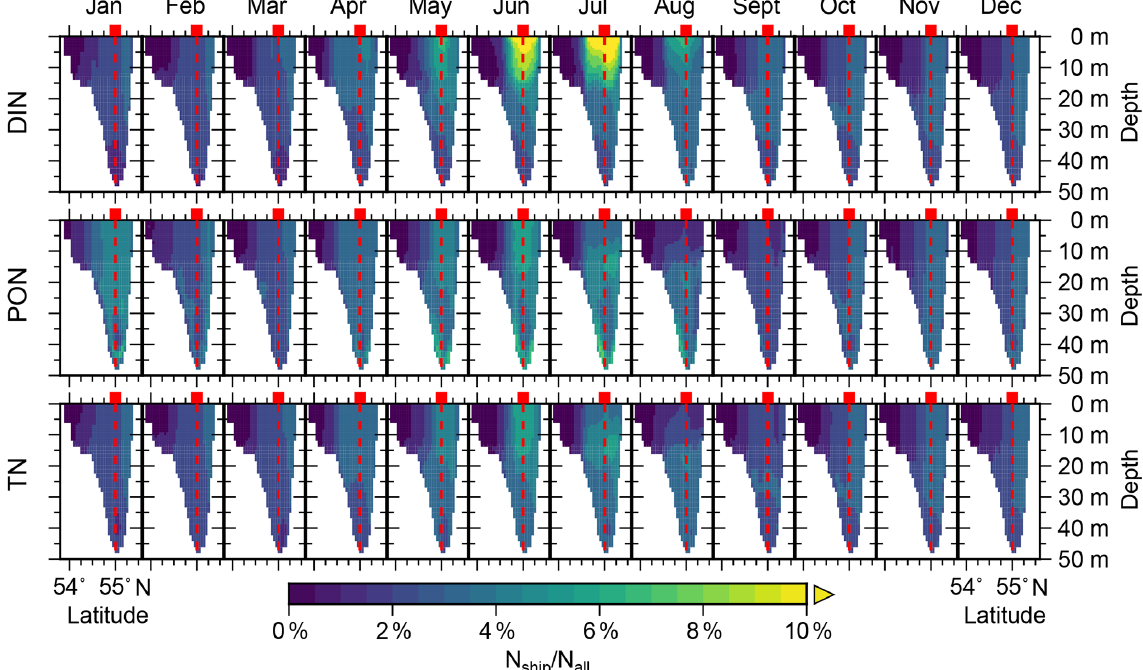
Figure 11. Cross section at 14.08333 ◦ N through the Arkona Basin (red line in Fig. 3) showing the contribution of shipping nitrogen to all nitrogen in dissolved inorganic nitrogen (DIN, top) and total nitrogen (TN, bottom). Each column shows data for one month: January to December 2012 from left to right. The location of station BY2 is indicated by a red symbol at the sea surface. The vertical red dashed line represents the measurement profile taken at this